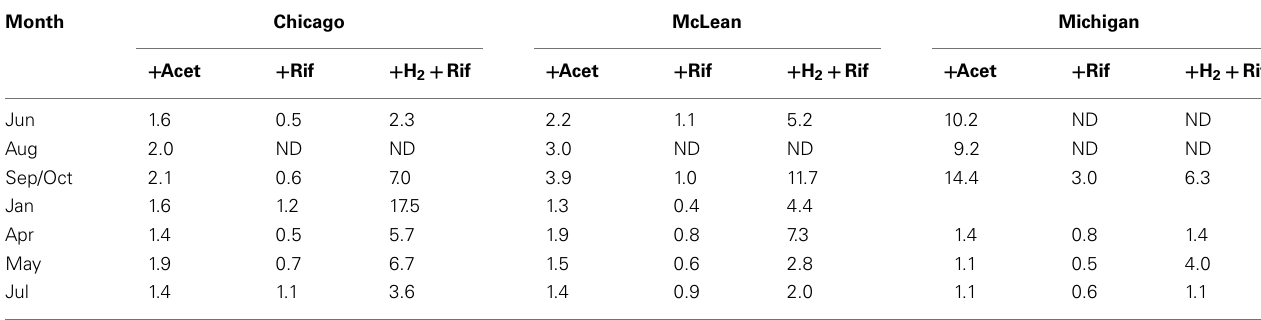
Table 3 | Ratio for the rate of CH 4 production with added substrate versus un-amended control. Month Chicago McLean